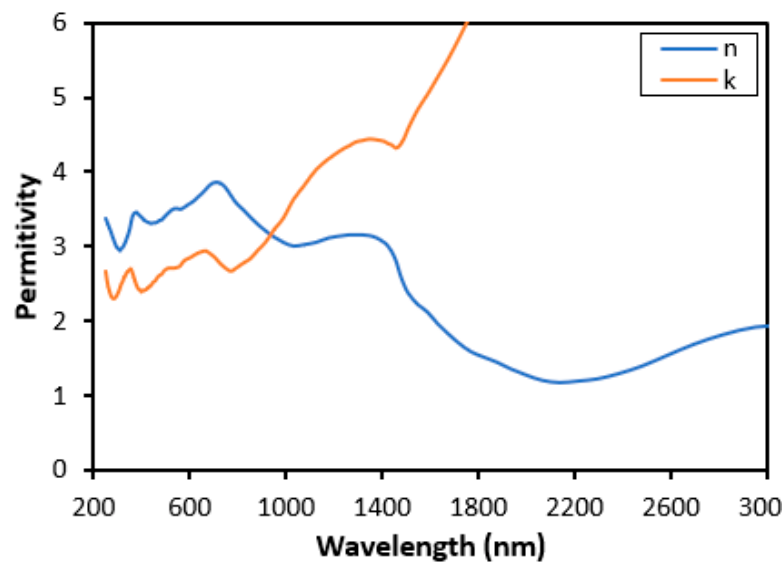
Figure 2. The real and imaginary part of the permittivity of the Tungsten.